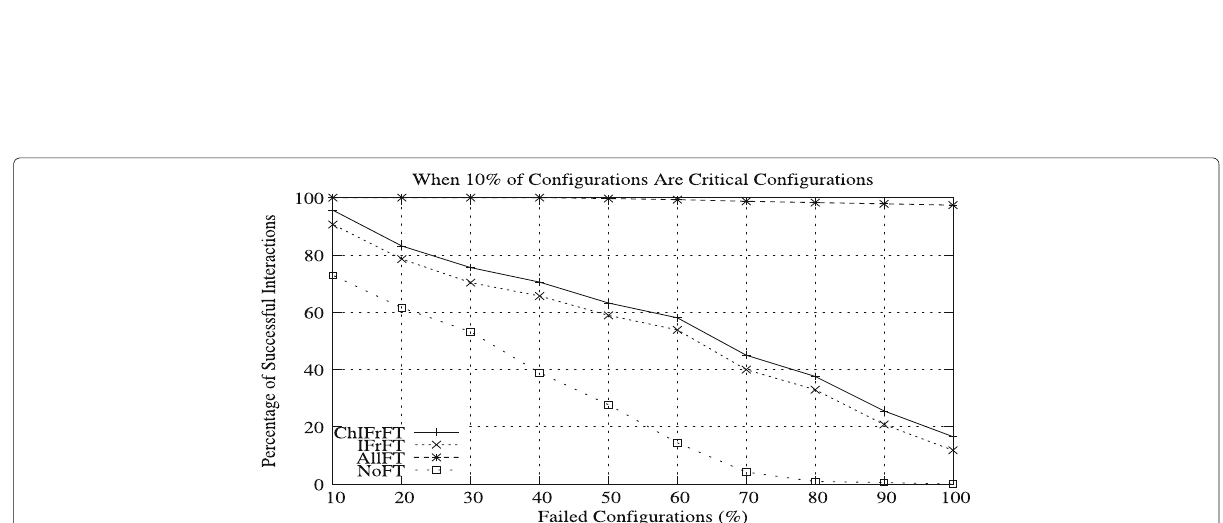
Fig. 10 Critical configurations are 10% of all configurations